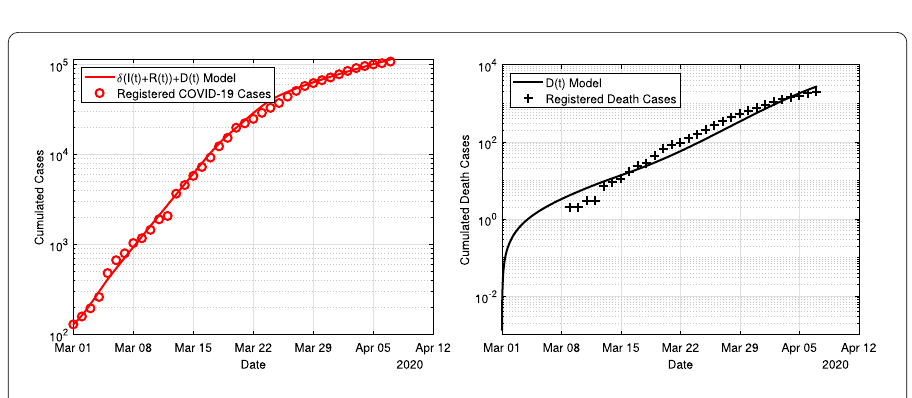
Figure 7 Fit of the delay model (4a)–(4e) to the data for the period 1 March to 7